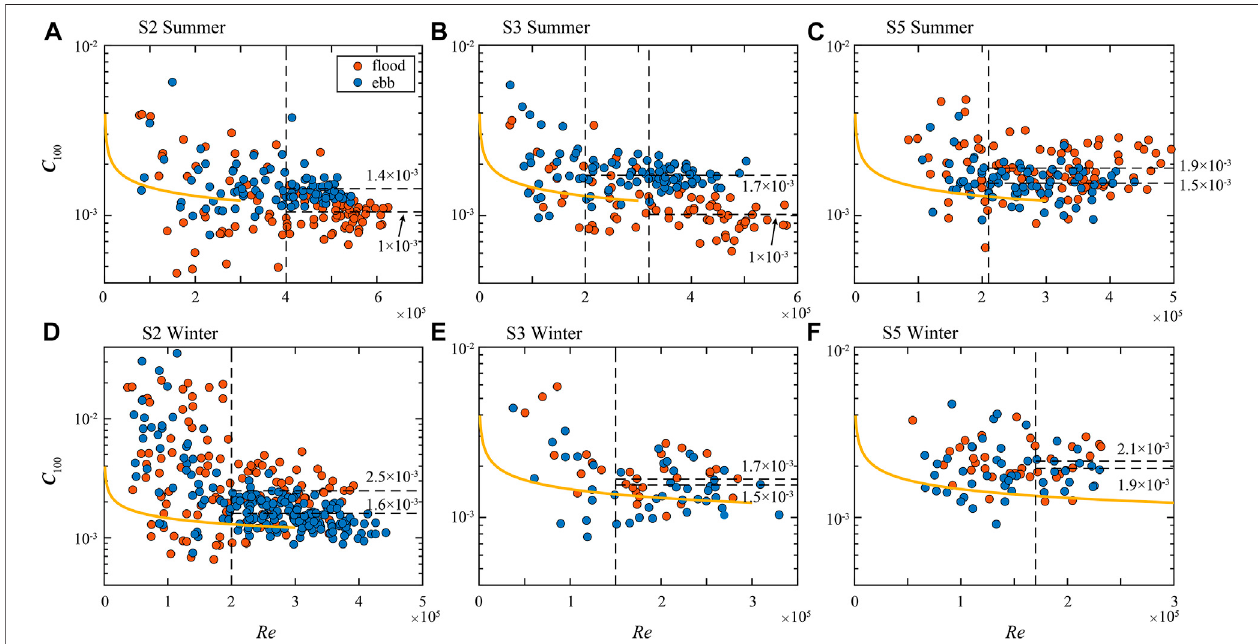
FIGURE 11 | Scatter plots of drag coef fi cient estimated at 1 mab, C 100 , versus the Reynolds number ( Re ) for the (A,B,C) summer and (D,E,F) winter. The orange scatters represent the fl ood tide, and the blue scatters represent the ebb tide. The vertical dashed lines are the boundary between regions of relatively large and small dispersion. The horizontal dashed lines are the mean value of C D the right-hand side of the boundary. The yellow lines are the empirical relationship under the assumptions for smooth fl ow.